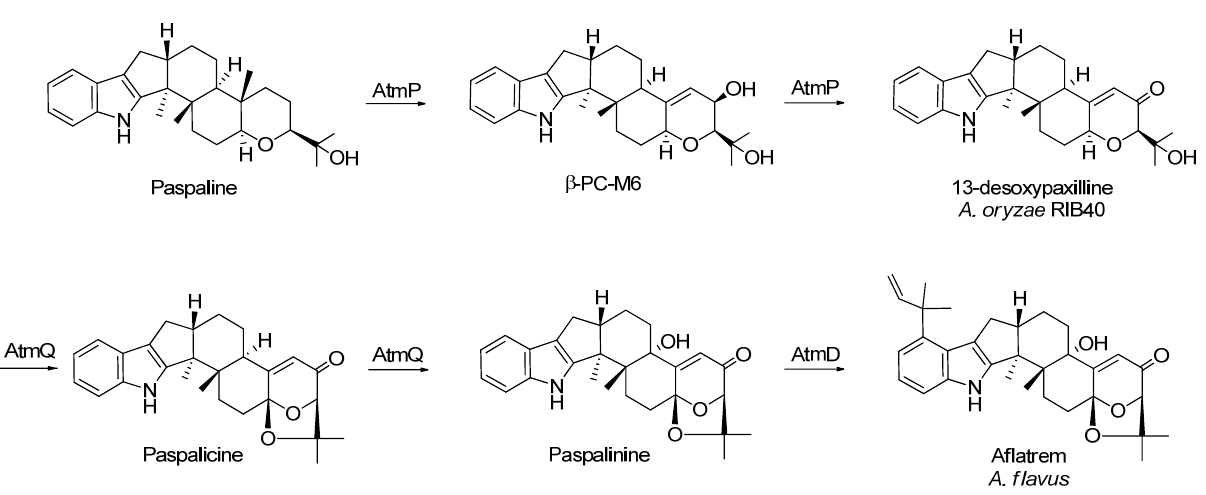
Figure 3. The final steps in the proposed biosynthesis of aflatrem (in A. flavus ). A. oryzae RIB40 biosynthesis stops at 13-desoxypaxilline